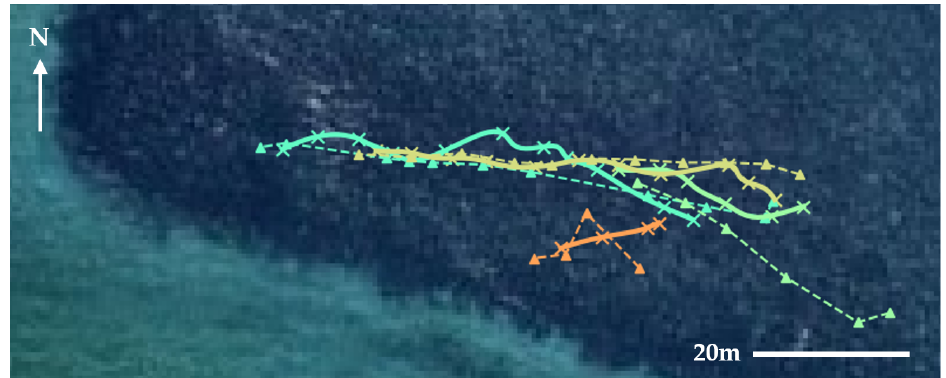
Figure 7. Comparison of WPTs with GPS surfer tracks on the reef. - Δ - = GPS points; -×- = Gaussian- smoothed WPTs time synchronised with GPS points at 1 Hz. Table 1. GPS tracks compared with WPTs in the reef region.